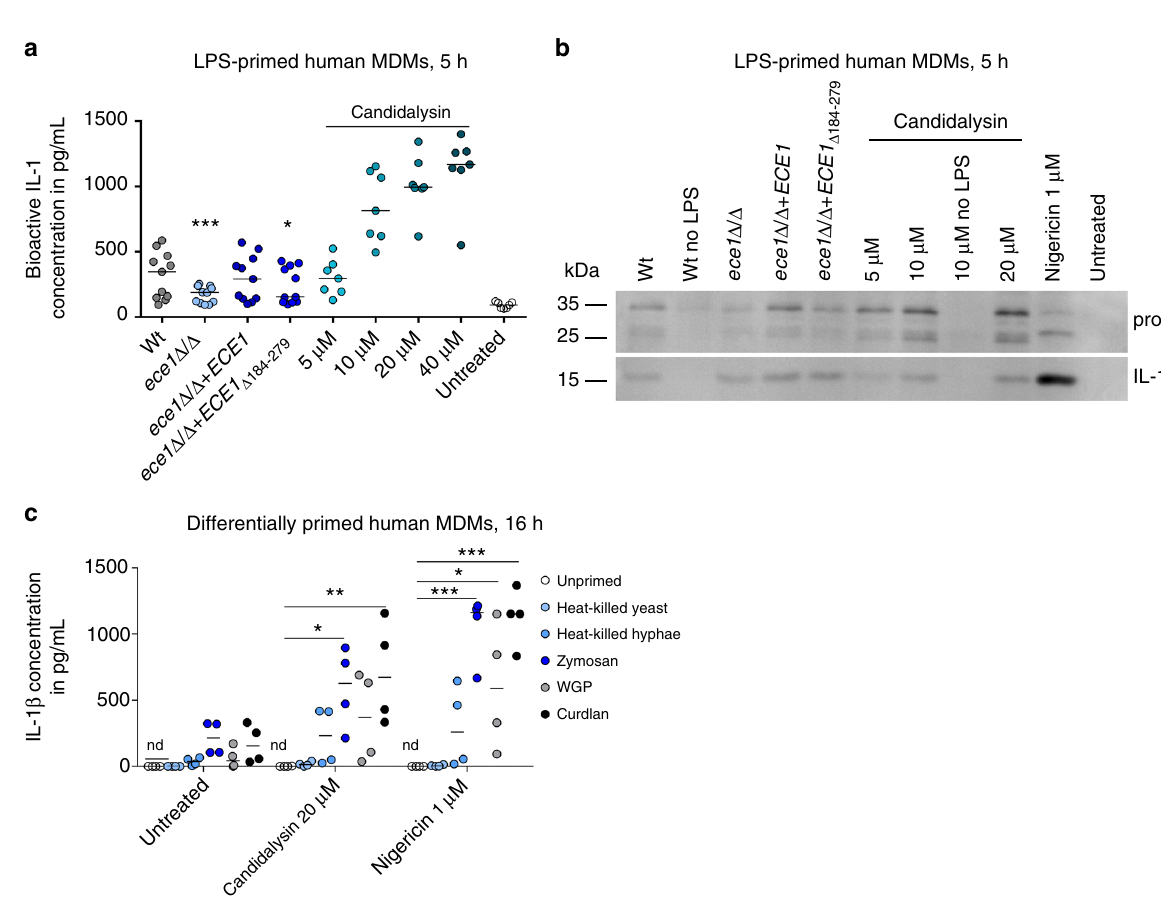
Fig. 3 Candidalysin-dependent release of bioactive, mature IL-1 β by primed hMDMs. a Levels of bioactive IL-1 measured in culture supernatants of LPS- primed hMDMs that were infected with C . albicans Wt, re-integrant ( ece1 Δ / Δ + ECE1 ) or mutant strains ( ece1 Δ / Δ , ece1 Δ / Δ + ECE1 Δ 184 – 279 ) (MOI 10) or co-incubated with synthetic Candidalysin. Bioactive IL-1 was quanti fi ed by stimulation of EL4.NOB-1 cells culture supernatants and correlation of the secreted murine IL-2 to a concentration range of recombinant human IL-1 β . b The presence of processed IL-1 β (p17) detected by western blotting in the supernatant of LPS-primed or unprimed (no LPS) hMDMs that were infected with C . albicans Wt, re-integrant ( ece1 Δ / Δ + ECE1 ) or mutant strains ( ece1 Δ /